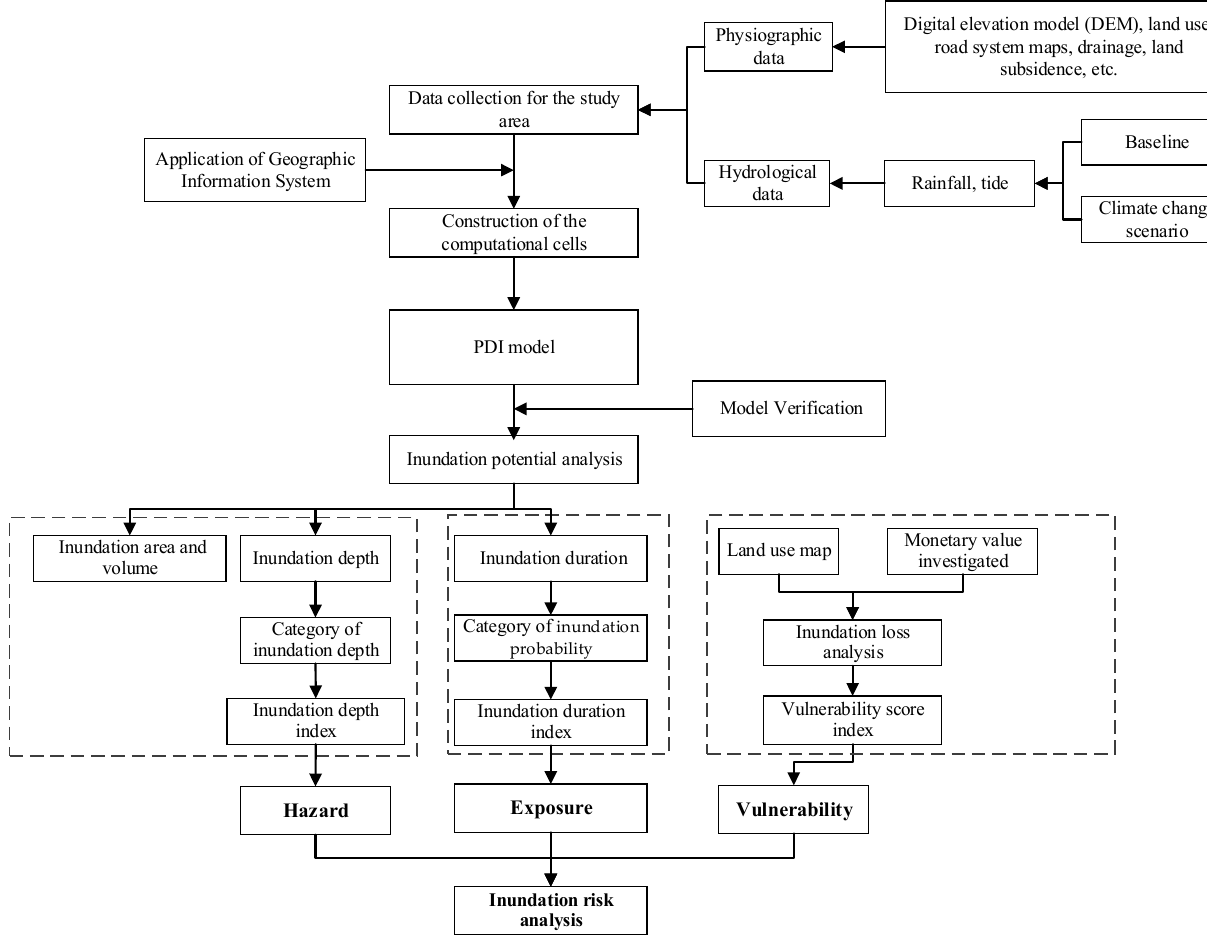
Figure 2. The flowchart of inundation risk analysis. PDI, Physiographic Drainage-Inundation.